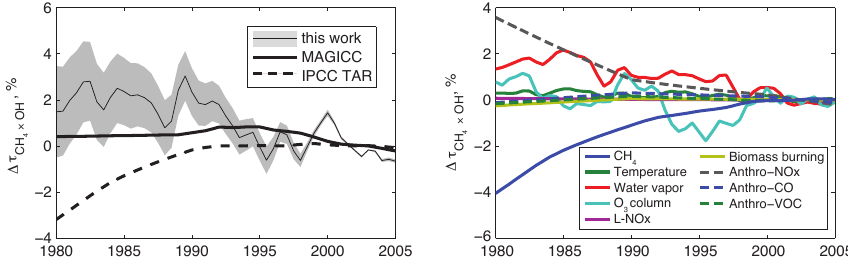
Fig. 5. Recent historical τ CH variation (left) and its component causes (right). Lifetime reconstructed in this work from Eq. (3), with 4 × OH components shown at right. Shaded region shows ± σ uncertainty propagated from adopted parameter ranges in Table 2, but not including possible errors in reanalysis meteorology, ozone column observations, or emission inputs. All data are anomalies with respect to their 2000– 2005 means. The anthropogenic (anthro) NO x component combines the separate effects of land, ship, and aircraft emissions. See Fig. S6 for uncertainties in each component.